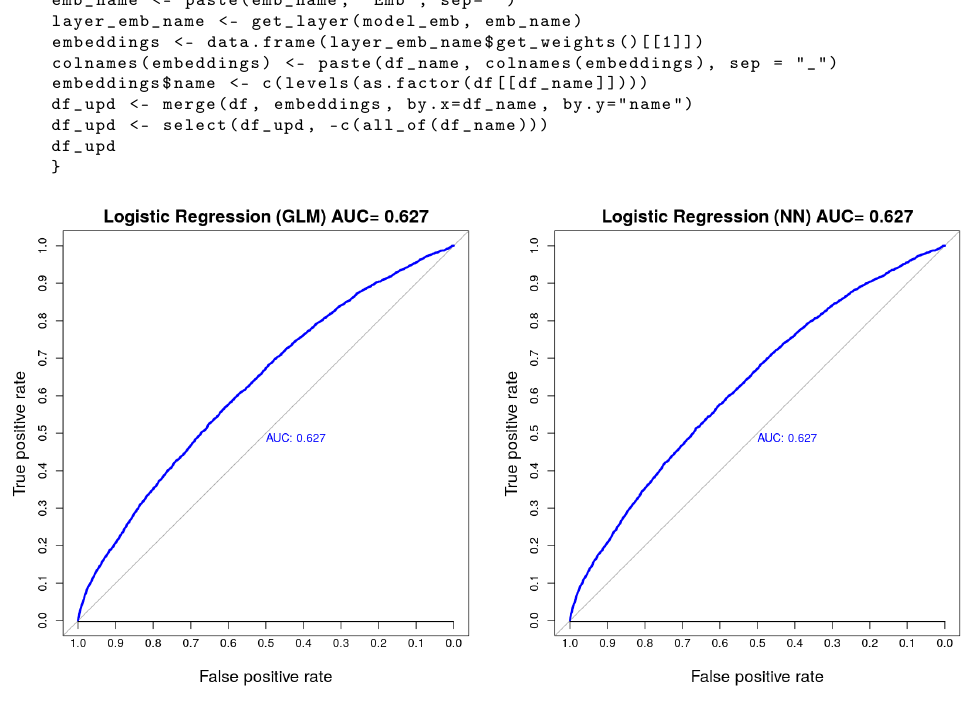
Figure 3. AUC values on the test set achieved using R’s logistic regression function ( left ) and logistic regression by a shallow neural network ( right ).